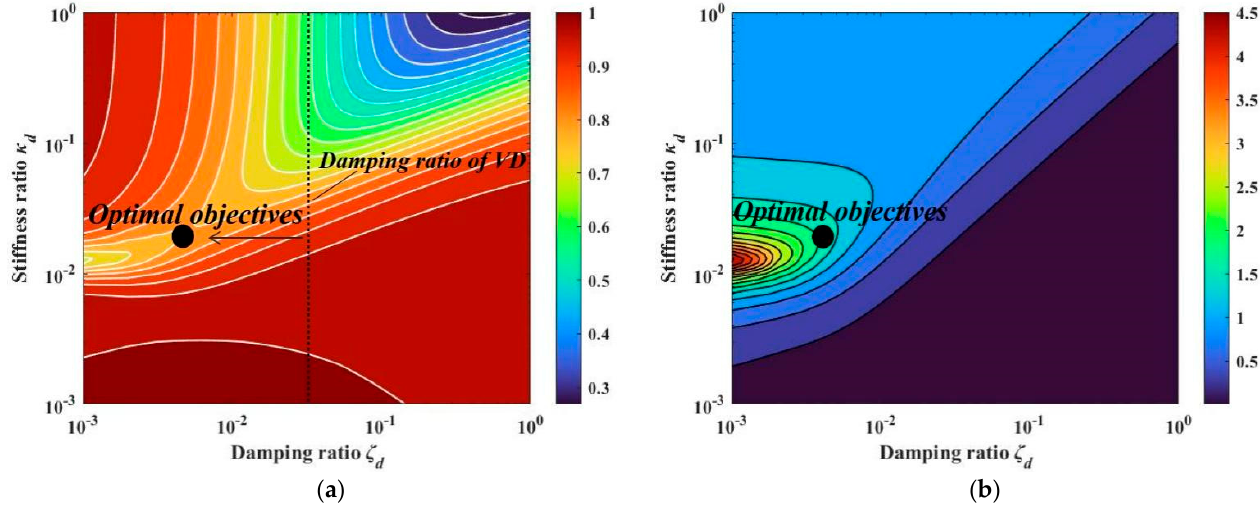
Figure 22. 2D Contour plot of γ U and γ Ud of eave with optimal μ d ( β = 0, γ U = 0.7): ( a ) γ U ; and ( b ) γ Ud .